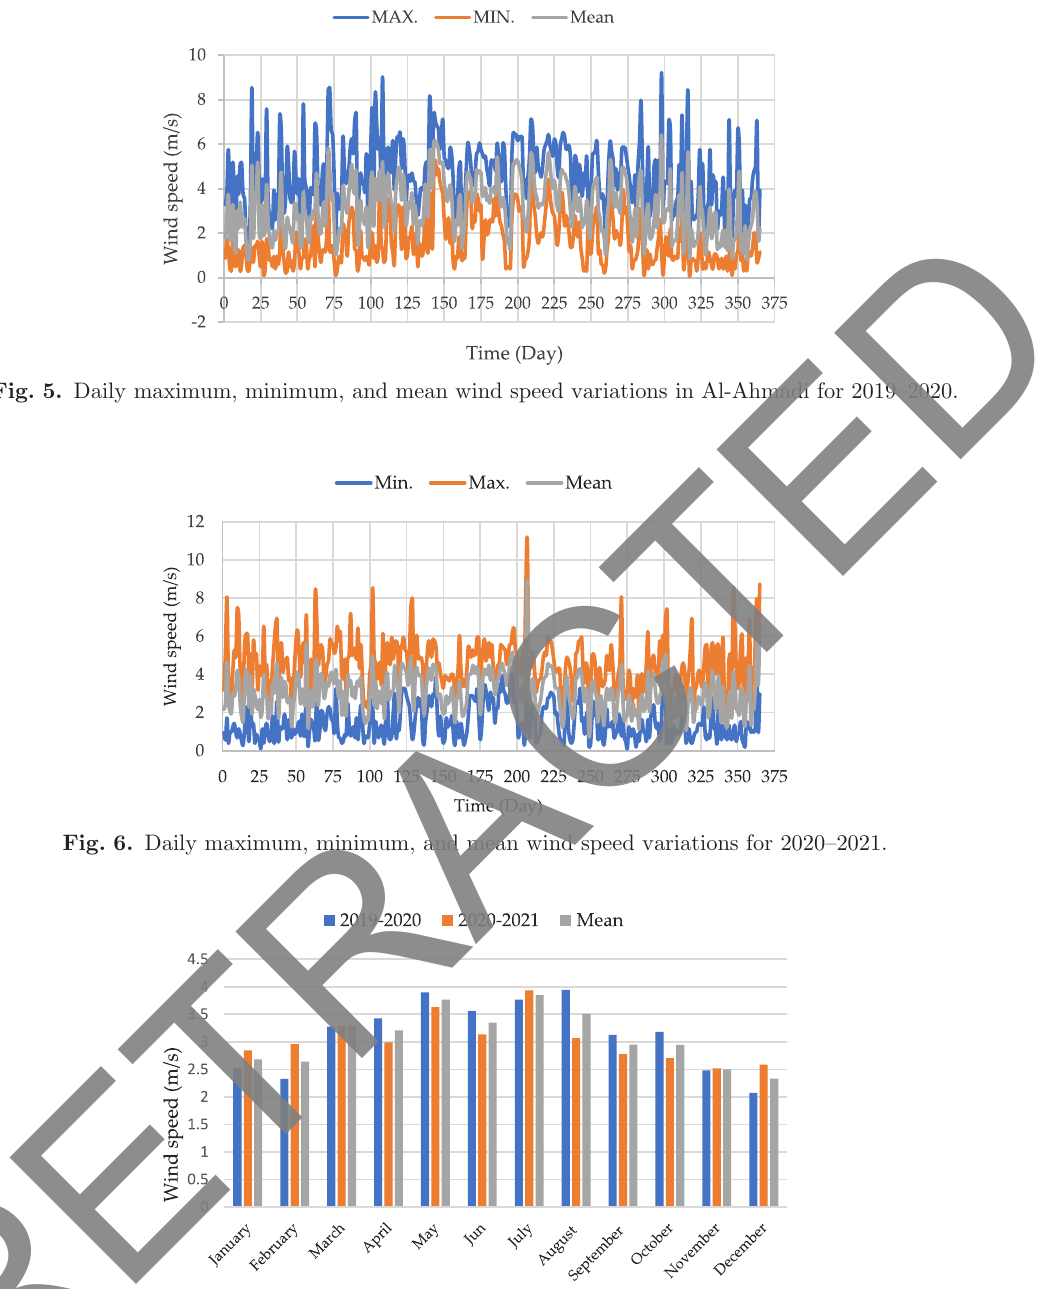
Fig. 7. Monthly mean wind speed variations for 2019 –